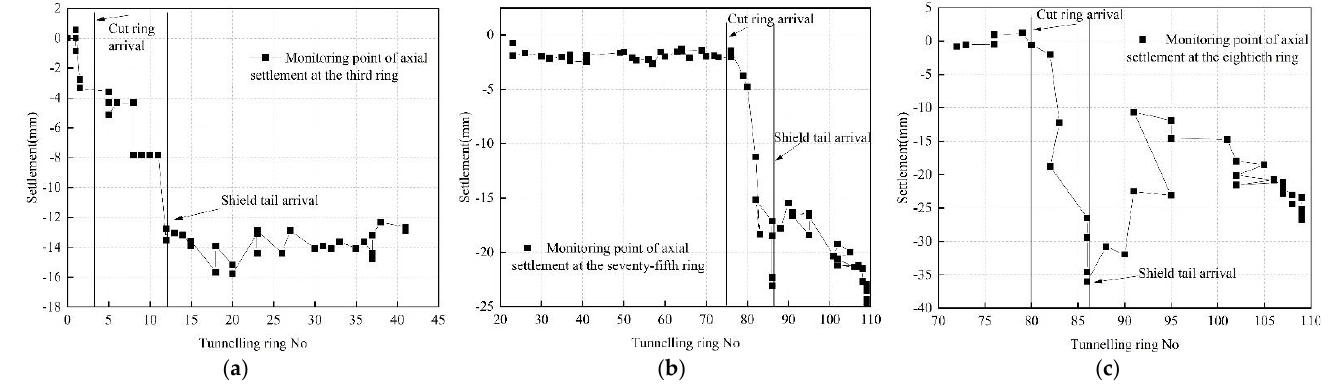
Figure 2. Surface settlement monitoring curve ( a ) Surface settlement duration curve of the axis at ring 3; ( b ) Surface settlement duration curve of the axis at ring 75; ( c ) Surface settlement duration curve of the axis at ring 80.